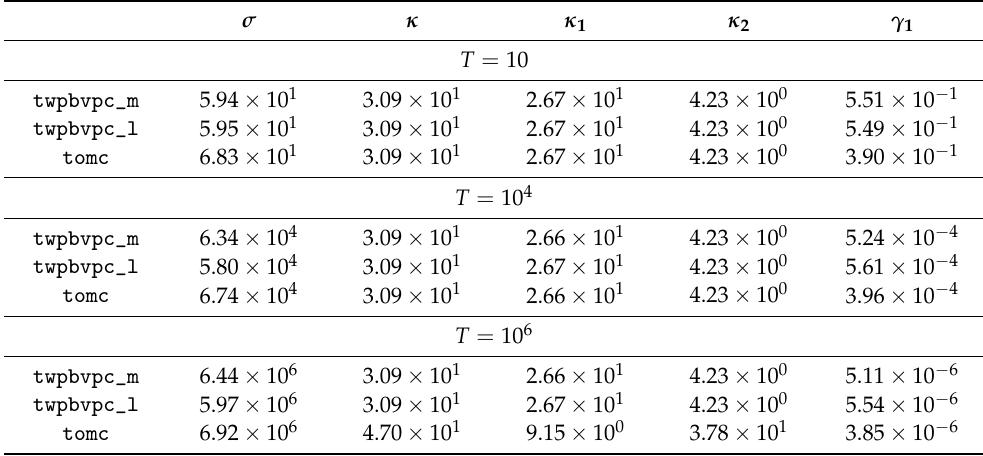
Table 8. Hypersensitive problem: conditioning parameters computed using tol = 10 − 6 and initial mesh with 11 equidistant points.